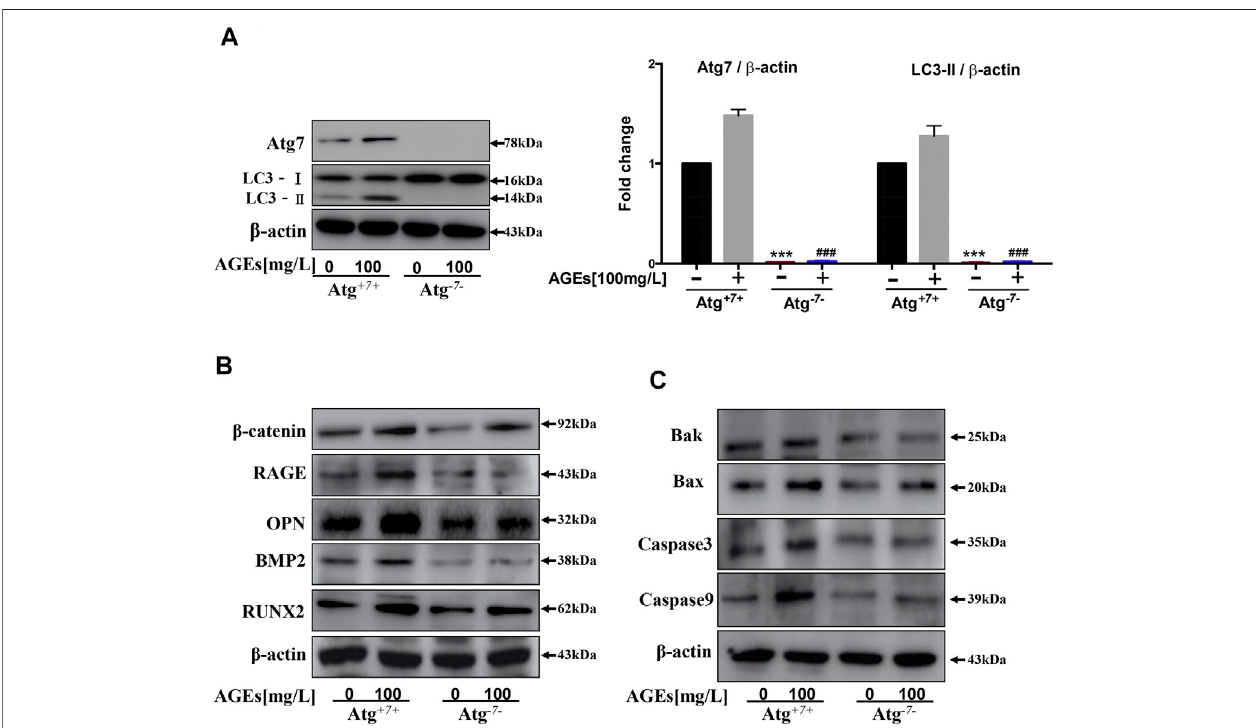
FIGURE7| Atg7knockoutcanreduceAGEs-inducedapoptosisandcalci fi cation.CellsweretreatedwithAGEsfor24 h. (A) ChangesinproteinexpressioninAtg7 knockout HASMCs. Western blot analysis of LC3 and Atg7. (B) Western blot analysis of calci fi cation-related proteins ( β -catenin, Runx2, OPN, and BMP2) in AGEs- treatedHASMCswithorwithoutAtg7knockout. (C) Westernblotanalysisofapoptosis-relatedproteins(Caspase3,Caspase9,Bax,andBak)inAGEs-treatedHASMCs withor withoutAtg7 knockout. Eachpoint represents themean ± SD( n (cid:2) 3/group). *** p < 0.001 and ### p < 0.001 versusAtg7and LC3expression levelinWT cells respectively, t -test